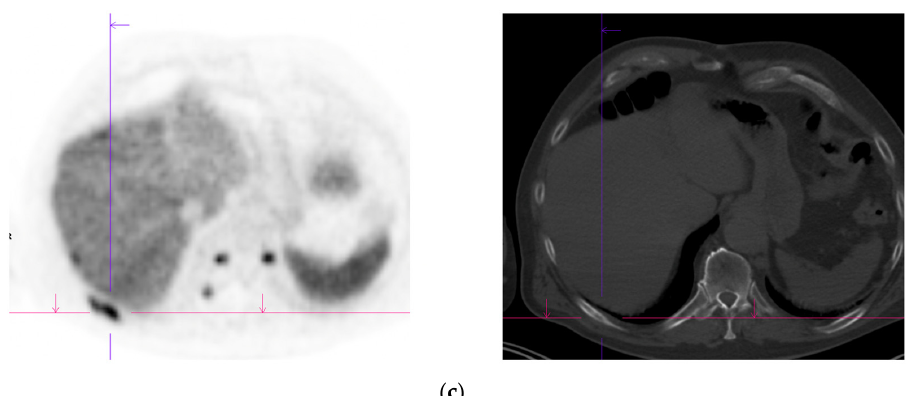
Figure 3. Recurrent disease. 74 yr old M; radical prostatectomy 8 yrs prior; extensive para-aortic and upper pelvic lymph node involvement on CT; severe back pain; PSA 60. PSMA PET-CT: 68 Ga-PSMA- 216 MBq; uptake 48 min; BMI = 31.9; Wt 89 kg. ( a , b ): Coronal and sagittal images show bulky nodal disease with markedly increased uptake (SUV = 68.2) in abdomen and pelvis, hepatic metastases, multiple bony metastases in pelvis, lower limbs, sternum, ribs and vertebral column. ( c ): enlarged transaxial images of lower thorax/upper abdomen show tracer avid foci in segments 7 (SUV = 8.8), 4 (SUV = 8.7) of liver; X-hairs on lesion in right 10th rib, SUV = 14.6; CT on bone windows shows small region of sclerosis vs. extensive uptake on PET.